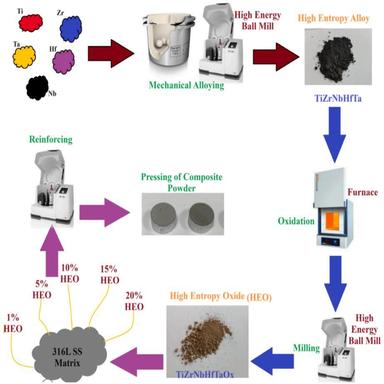
Schematic view of reinforcement and composites production.